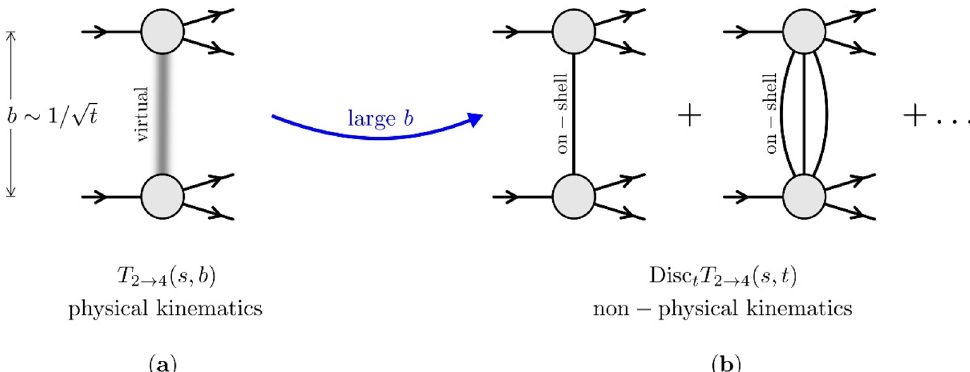
Figure 8 . (a) We consider a scattering experiment at fixed impact parameters b . This process is controlled by the exchanged momentum t ∼ 1 > 0 . (b) At large impact parameters the amplitude b 2 can be organized as a sum over on-shell particles exchange. The dominant contribution comes from the exchanged of the lightest on-shell